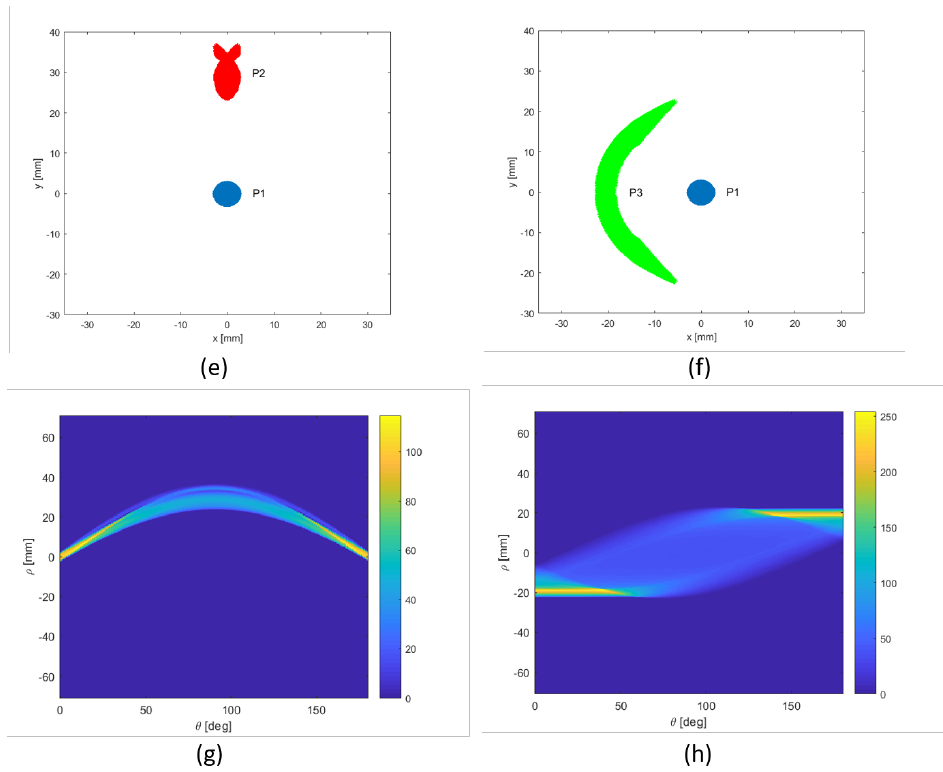
Figure 4. ( a , b ) Imposed RTs. ( c , d ) IRTs. ( e , f ) binary quantization of IRTs (Threshold values to binary quantization equal to 30% and 25% of maximum values of IRTs for sensors P2 and P3 respectively). ( g , h ) actual RTs. P2 and P3 are related to first and second column, respectively.